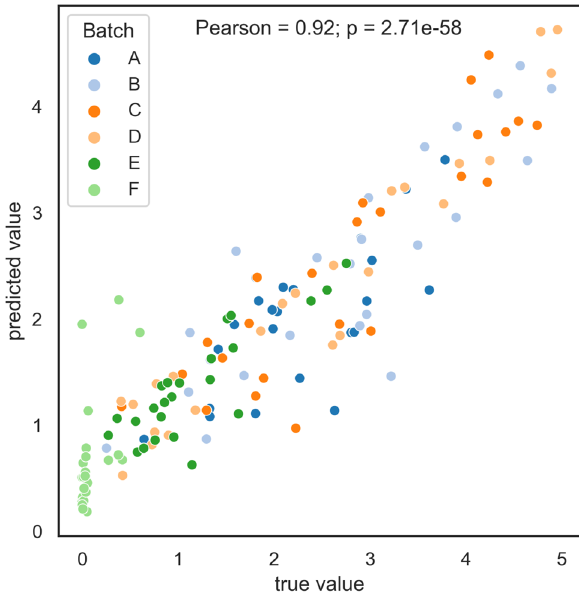
Figure 11. Aggregated true and predicted values at tomato